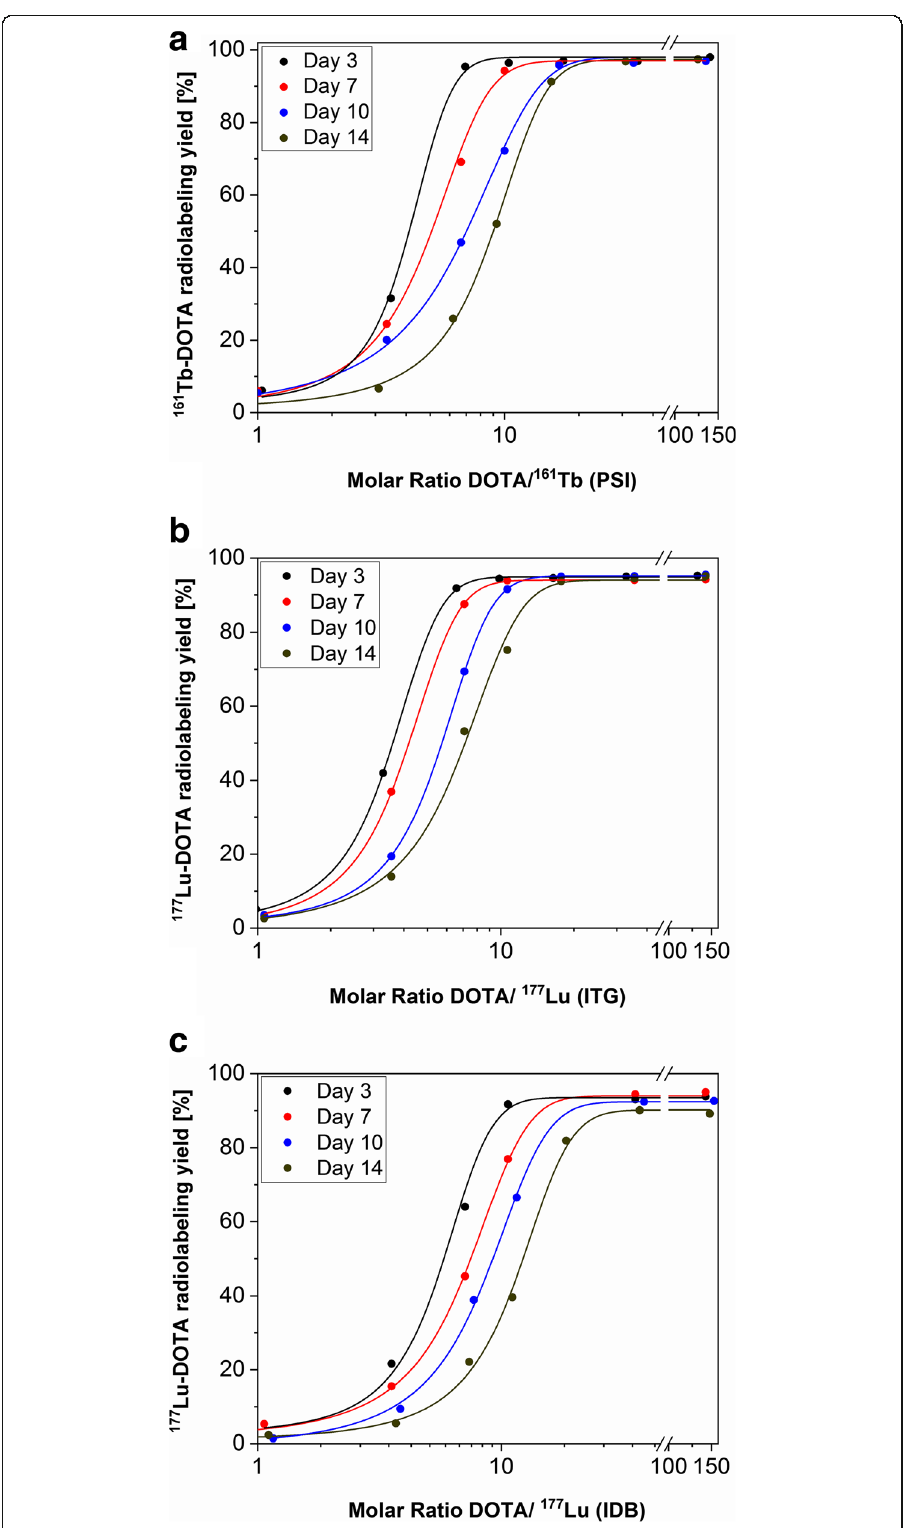
Fig. 5 Comparison of the radiolabeling yield of ( a ) no-carrier-added 161 Tb (SAFARI-1); b no-carrier-added 177 Lu (ITG) and ( c ) carrier-added 177 Lu (IDB) in combination with DOTA over time at different DOTA-to- nuclide molar